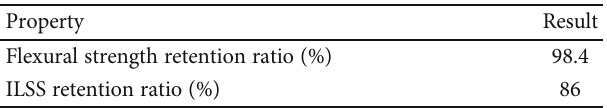
Table 4: Retention ratio of mechanical strength at 240 ° C for MDPES-2 composite.